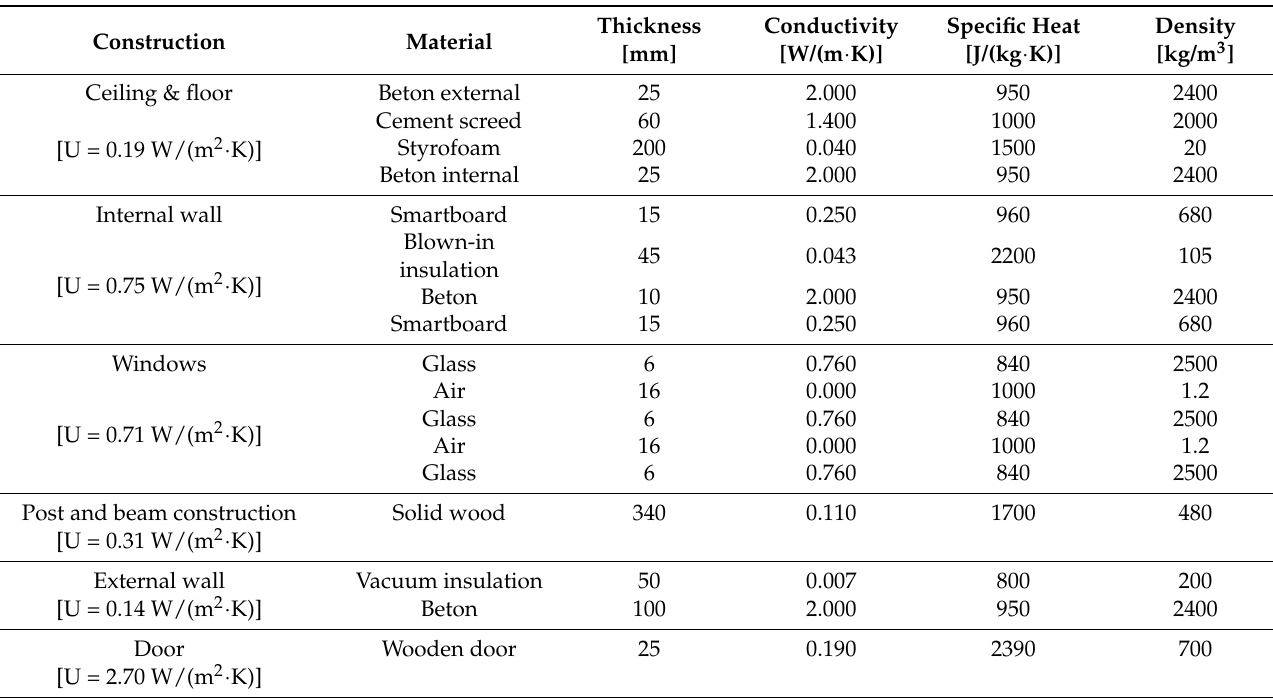
Table A1. Thermal properties of construction elements: office room [17]. Values obtained from Ubakus online calculator [52].